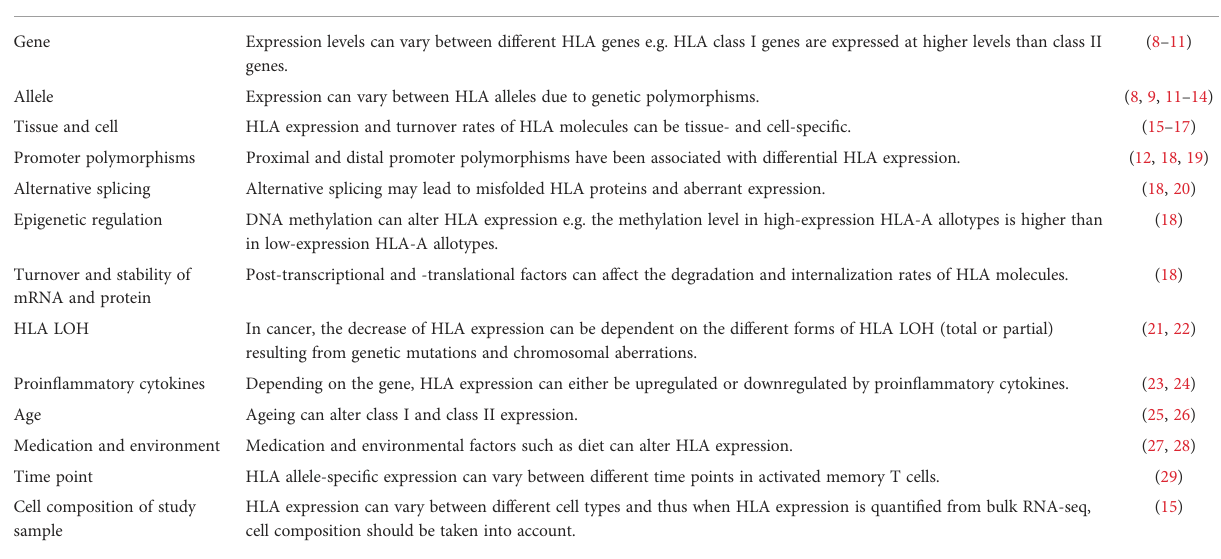
TABLE 1 Factors associated with differential HLA expression